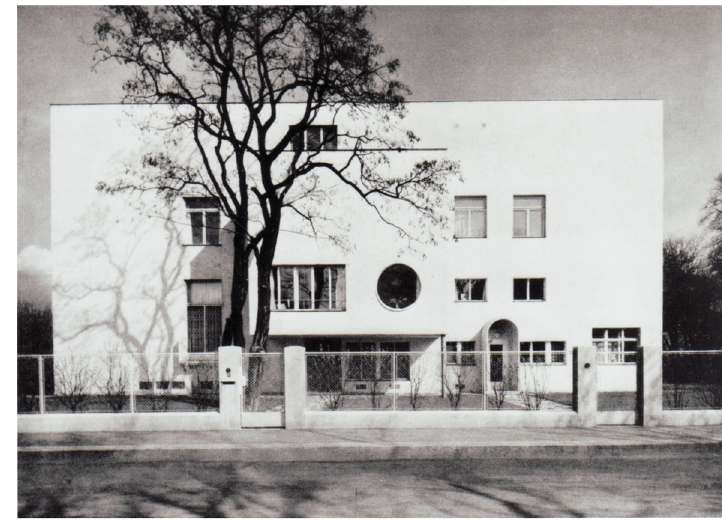
Fig. 2 Villa Beer, Vienna-Hietzing (1930), west façade (Source: Julius Scherb, Vienna